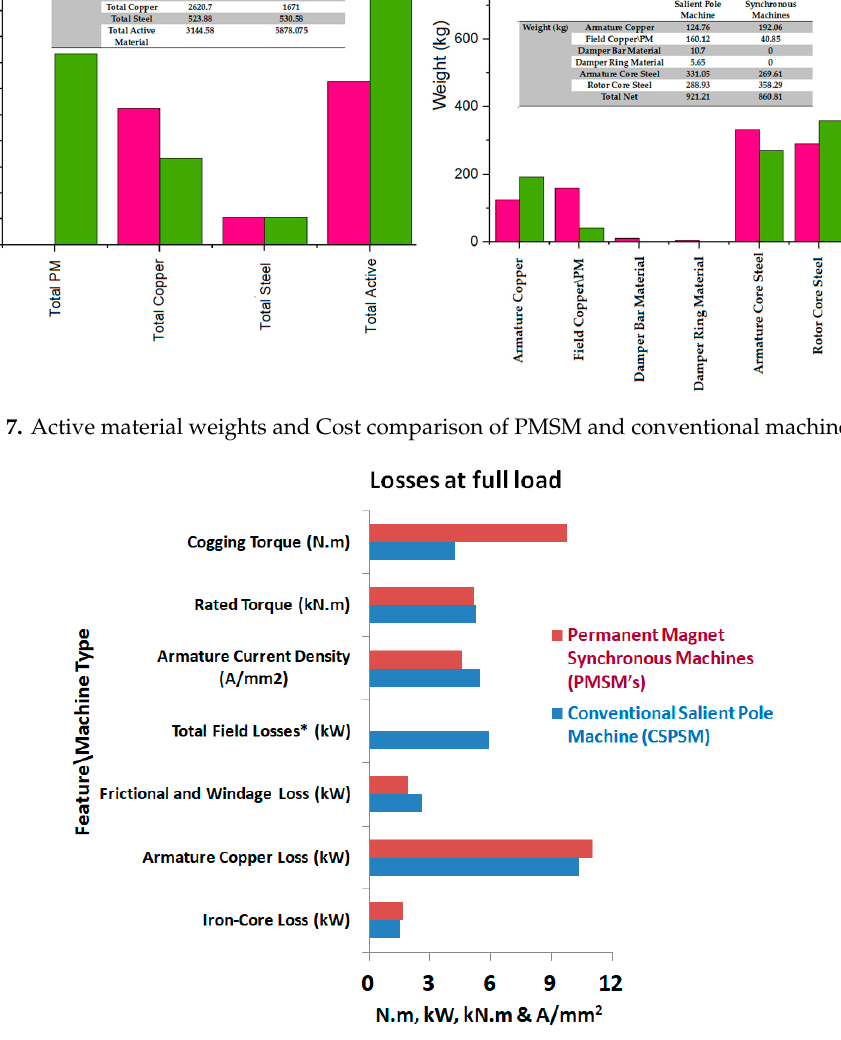
Figure 8. Losses comparison for PMSM and conventional machines at full load conditions [27].